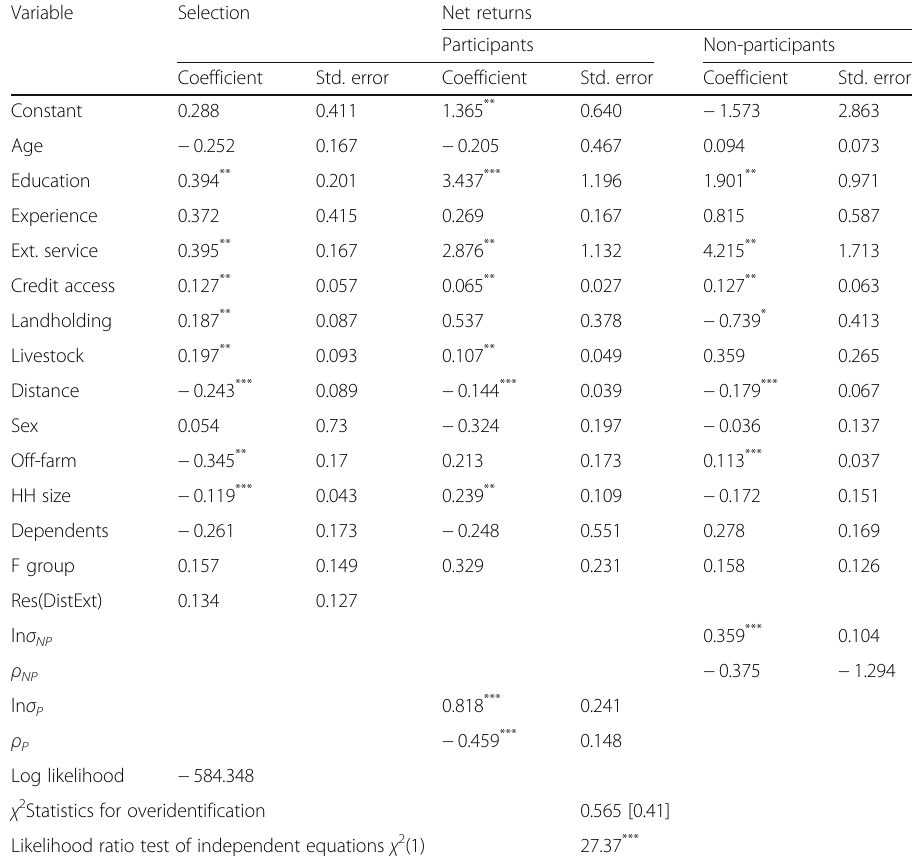
Table 3 Determinants of dairy hub participation and the impact of participation on net returns Variable Selection Net returns